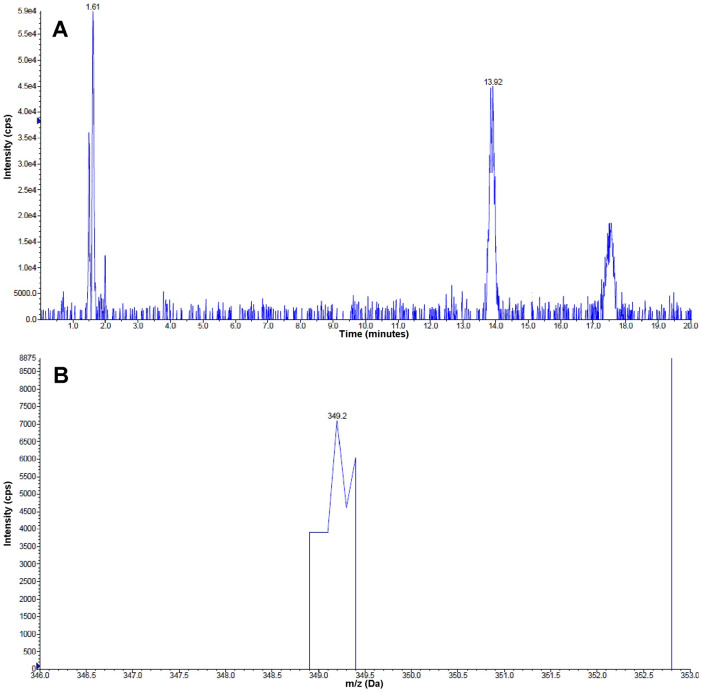
Identification of AFB1 monoalcohol by HPLC-MS.(A) Chromatogram of the purified AFB1 monoalcohol product obtained from the reduction of AFB1 dialdehyde with NaBH4. The peak at tR = 13.92 shows the putative AFB1 monoalcohol product. (B) Protonated monoisotopic mass found in the 13.92 min peak, corresponding to a value of 349.2 Da.